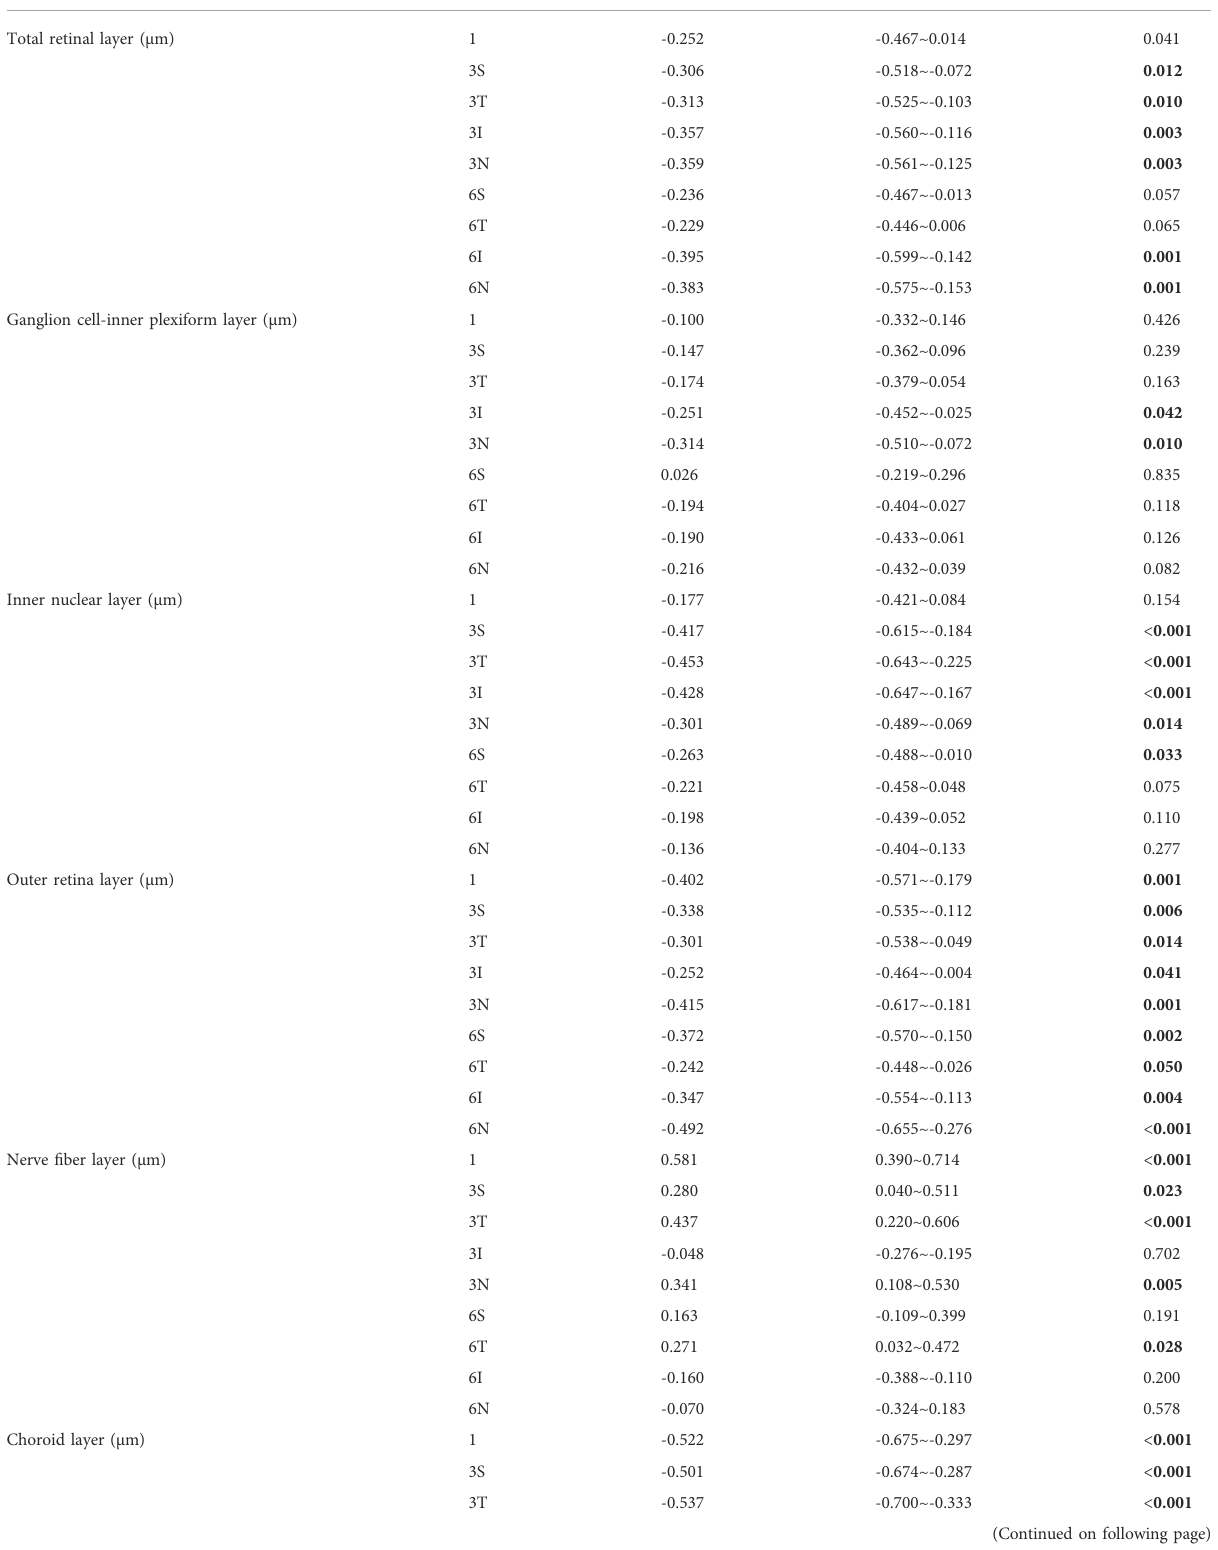
r 95% CI p-value s